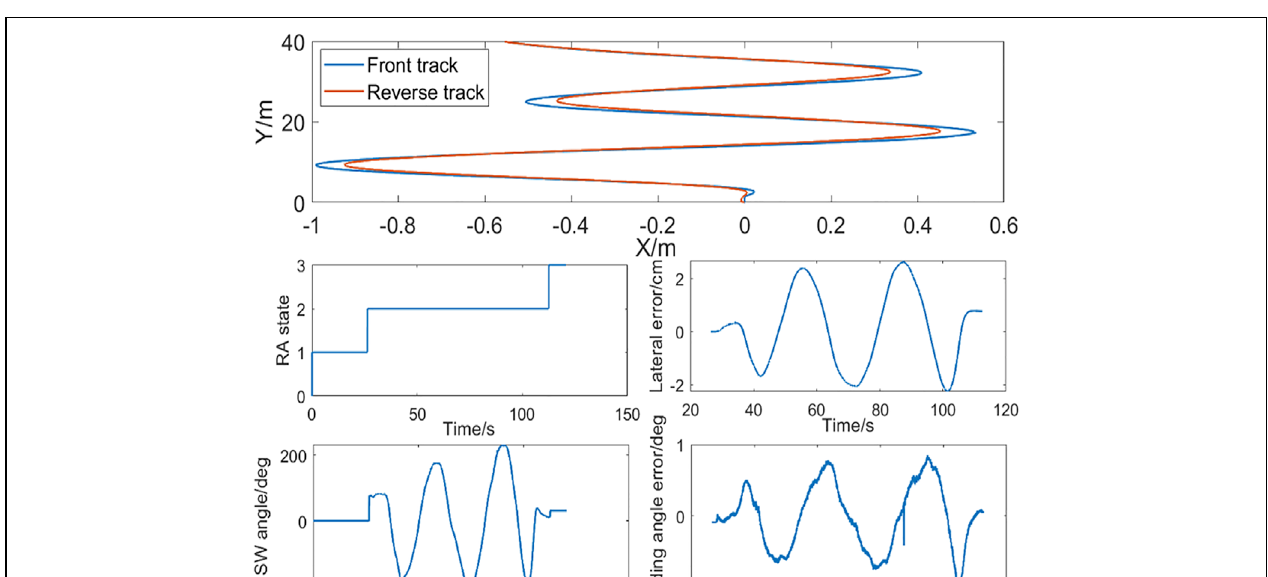
FIGURE 9 | RA in straight line condition.